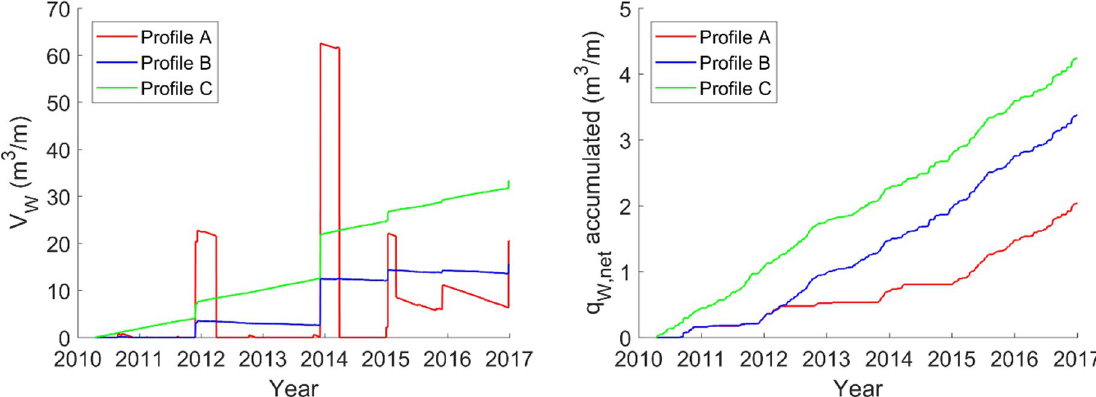
Fig 15. Available sediment for aeolian transport (V W ) and accumulated aeolian transport (q W ) during the calibration and validation